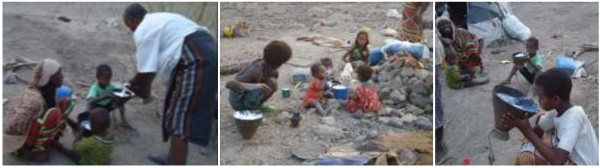
Raw milk consumption habit of the pastoral communities in the study areas.